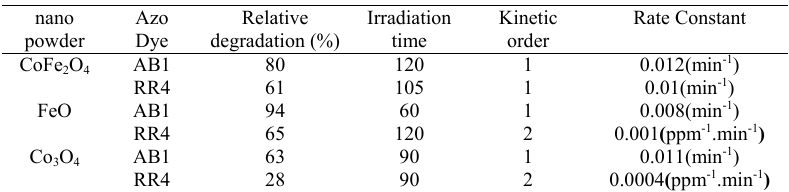
Fig.12. UV-Vis absorption spectra of Acid Black 1 degradation over FeO nanoparticles and picture of dye solution after 0 and 60 min UV irradiation. Table. 1 .degradation condition (irradiation time (min) , relative degradation (%) , kinetic order and rate constant) of AB1 and RR4 over photocatalysts.